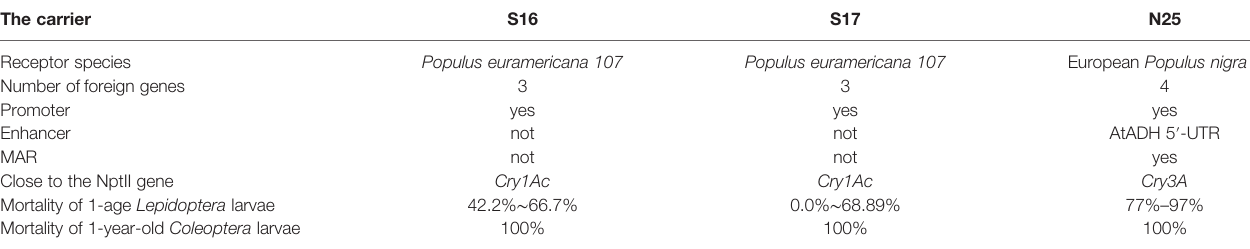
Mortality of 1-year-old Coleoptera larvae S16, S17, and N25 represent the carrier structures of Yang et al. (2016); Liu et al. (2016) and this experiment. The comparison data are from the above two references and the statistical data of this experiment.